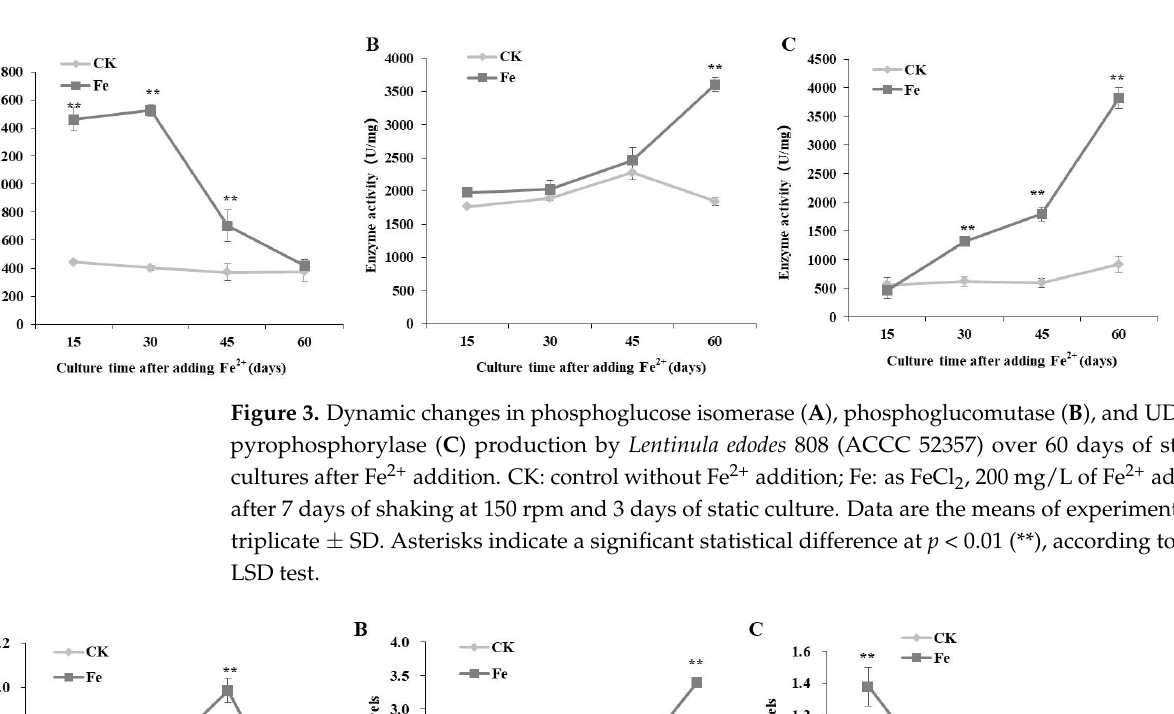
Figure 3. Dynamic changes in phosphoglucose isomerase ( A ), phosphoglucomutase ( B ), and UDPG ‐ pyrophosphorylase ( C ) production by Lentinula edodes 808 (ACCC 52357) over 60 days of static cultures after Fe 2+ addition. CK: control without Fe 2+ addition ; Fe: as FeCl 2 , 200 mg/L of Fe 2+ added after 7 days of shaking at 150 rpm and 3 days of static culture. Data are the means of experiments in triplicate ± SD. Asterisks indicate a significant statistical difference at p < 0.01 (**) and p < 0.05 (*), according to the LSD test. Table 1. Correlation coefficients between the intracellular polysaccharide (IPS) and exopolysaccharide